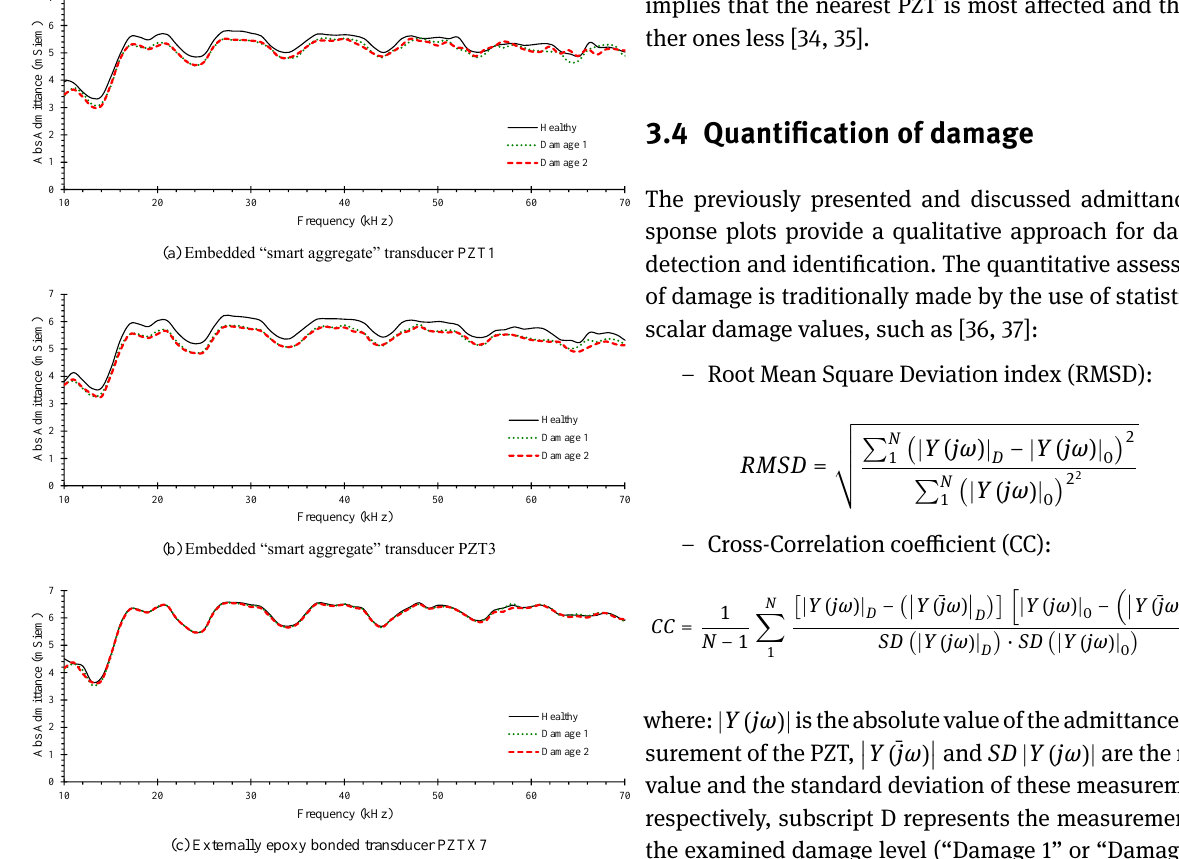
Figure 9. Comparisons of the Abs Admittance measurements of the PZTs between the healthy Figure 9: Comparisons of the Abs Admittance measurements of the state and the two damage levels (Damage 1 and Damage 2) of the RC beam PZTs between the healthy state and the two damage levels (Damage 1 and Damage 2) of the RC beam